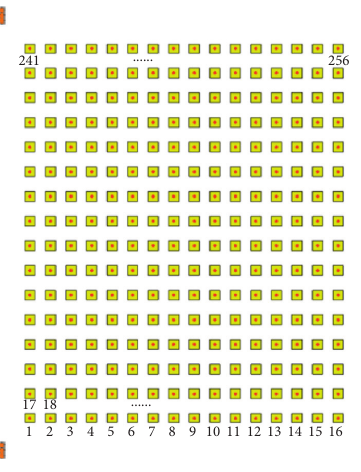
Figure 16: Matrix constraint condition.